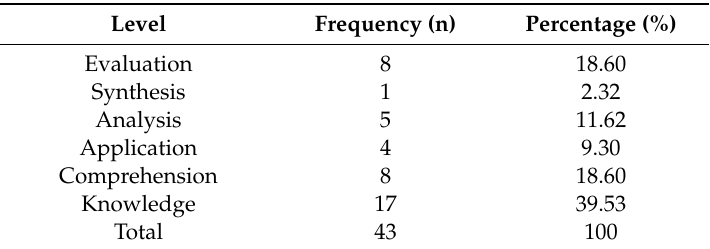
Table 5. Frequency (n) and percentage (%) of cognitive demand levels according to Bloom’s taxonomy for the concept of water